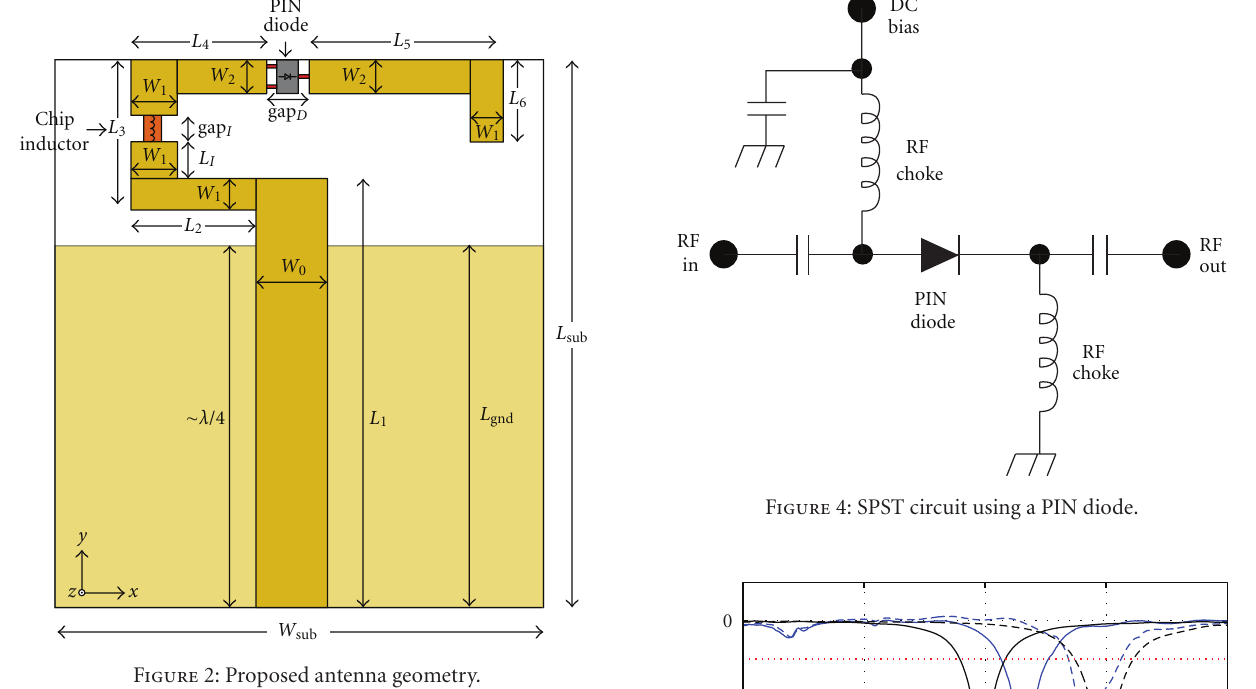
Figure 2: Proposed antenna geometry.